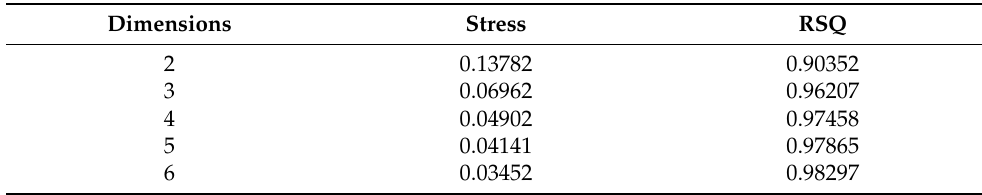
Table 3. The stress and RSQ values of different dimensions of multidimensional scaling (MDS)